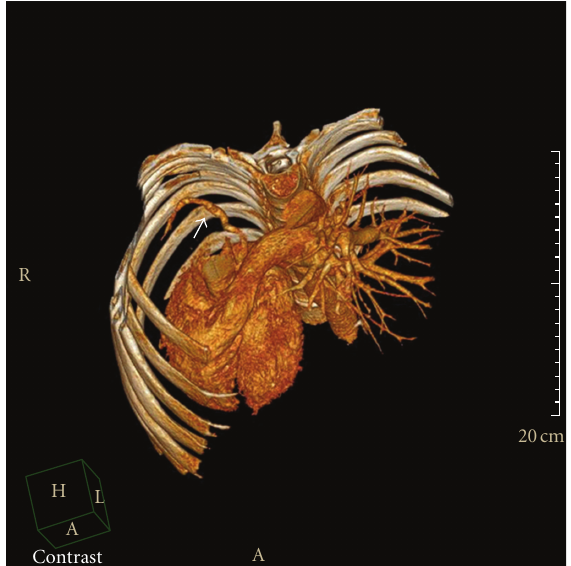
Figure 2: Coronal plane showing the anomalous venous drainage (white arrow).